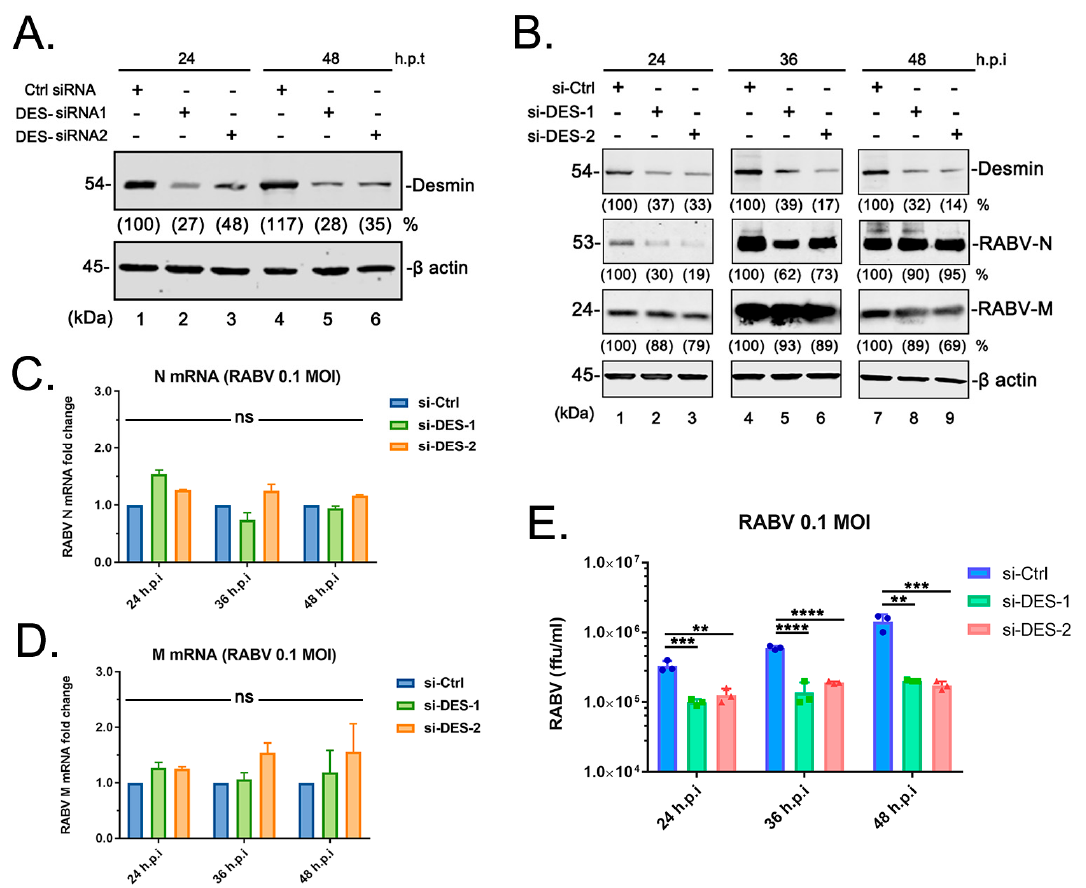
Figure 3. siRNA knockdown of endogenous desmin inhibits RABV infection. ( A ) BHK-21 cells were transfected with control or specific desmin siRNAs, the suppression of endogenous desmin levels was verified via WB and quantified using NIH Image-J software (1.53m 28, MD, USA). ( B ) BHK-21 cells received control or desmin siRNAs were infected with RABV (RC-HL strain) at an MOI of 0.1. The cell extracts were harvested at 24, 36, and 48 h.p.i, followed by WB analysis of desmin and viral proteins RABV-N and M, and β -actin served as a control. The indicated proteins were quantified using NIH Image-J software (1.53m 28, MD, USA). ( C , D ) RABV-N ( C ) and RABV-M ( D ) mRNA expression levels in infected cells were analyzed via qRT-PCR at 24, 36, and 48 h.p.i. Data were normalized to β -actin mRNA expression and are presented as relative fold change vs. controls. ( E ) Virus titration of the supernatants from infected cells at 24, 36, and 48 h.p.i. Statistical significance of bar graphs was analyzed by a one-way ANOVA. ns: not significant, **: p < 0.01, ***: p < 0.001, ****: p < 0.0001.